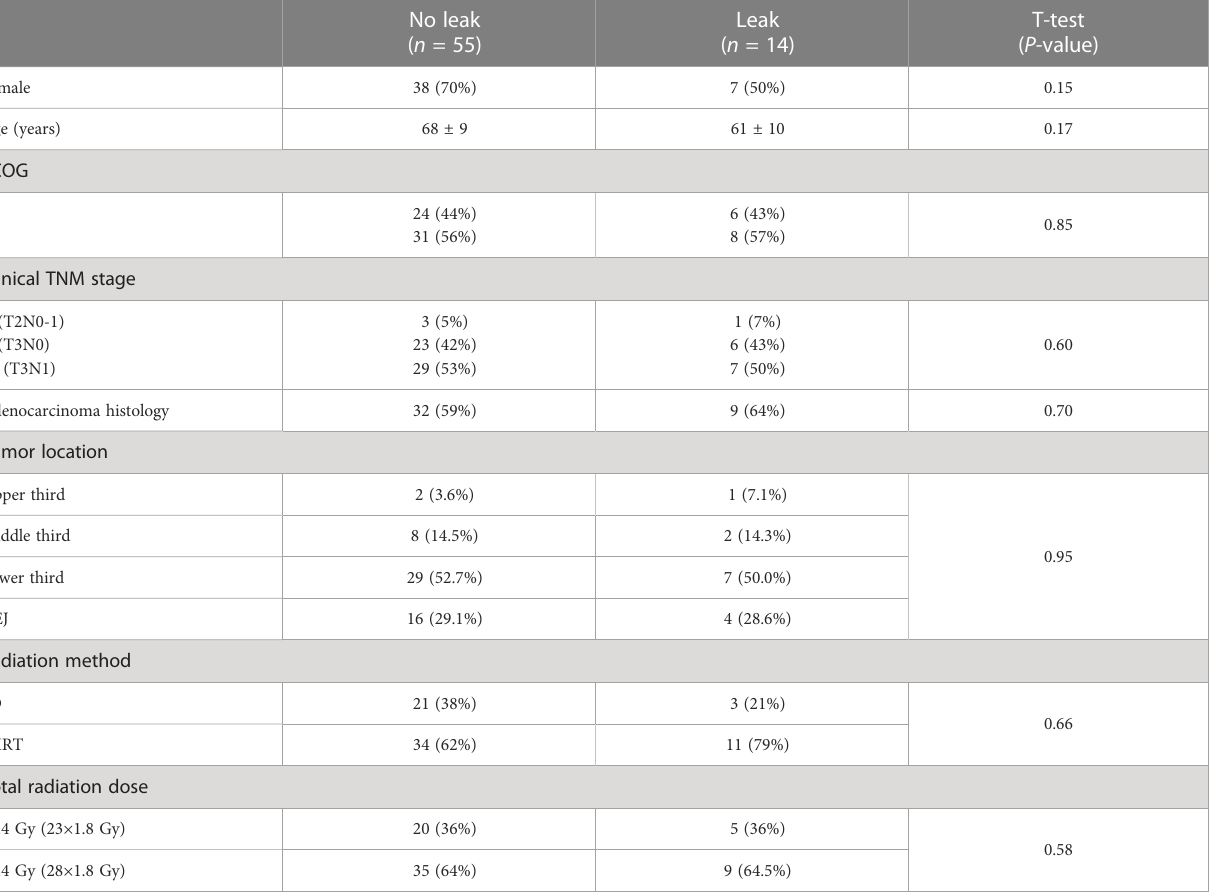
primary tumor location: 37 Gy for GEJ and lower third tumors